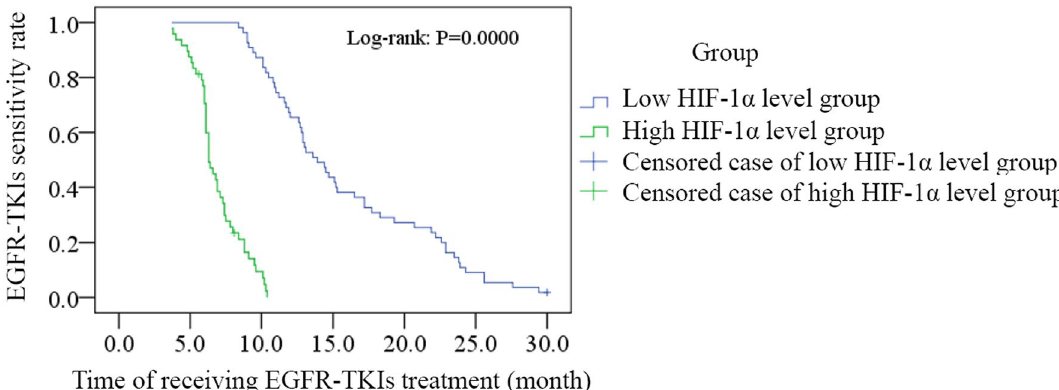
Figure 4. Kaplan–Meier analysis evaluated the EGFR-TKIs sensitivity rate of low HIF-1α level group and high HIF-1α level group in 30 months for 103 cases receiving EGFR-TKIs treatment . 103 EGFR-TKI sensitive mutation patients were divided into low HIF-1α level group (n = 55, ≤ median) and high HIF-1α level group (n = 48, > median) according to the median level of HIF-1α before receiving treatment. Vertical bars indicate cases with censored data. Kaplan–Meier survival analysis was conducted. As the treatment going on, EGFR- TKIs sensitivity rate of low HIF-1α level group was much higher than that of high HIF-1α level group (log-rank: P = 0.000).